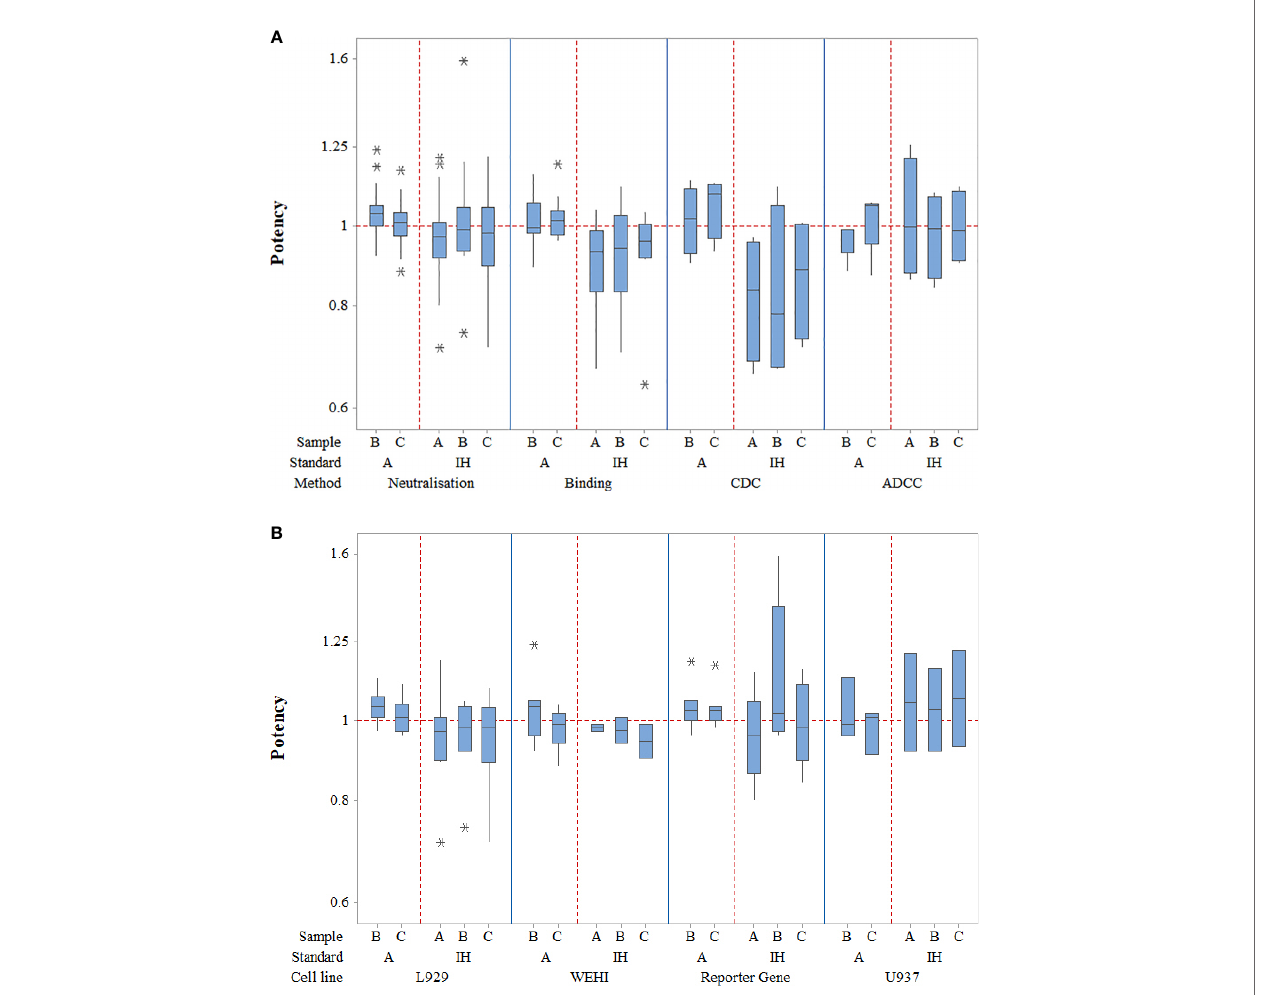
FIGURE 1 | Laboratorygeometricmeanrelativepotencyestimatesfor alldifferentassaytypes (A) aswellasfor thedifferent TNF- a cell-basedneutralizationassays (B) .Boxes representtheinterquartilerangeandthelineshowsthemedian. Thebars representtherangeand*shows outliersde fi nedas 1.5